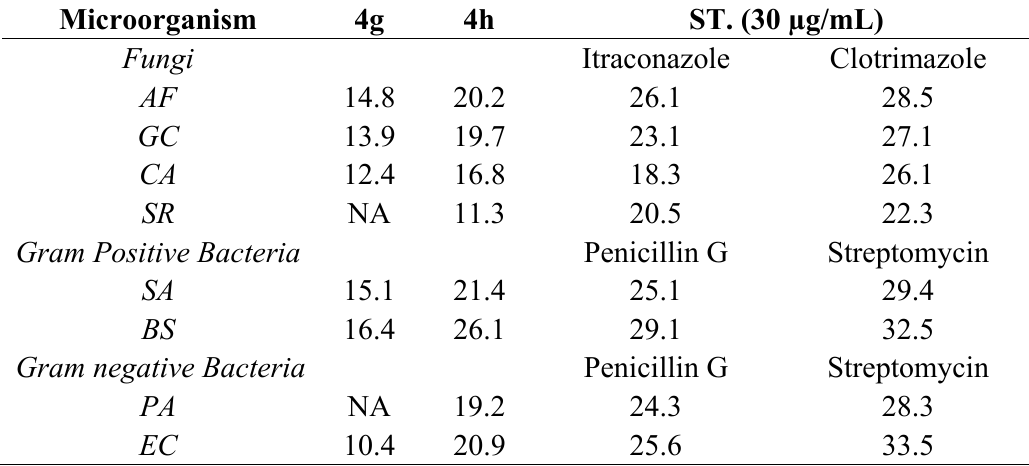
Table 5. Anti-microbial